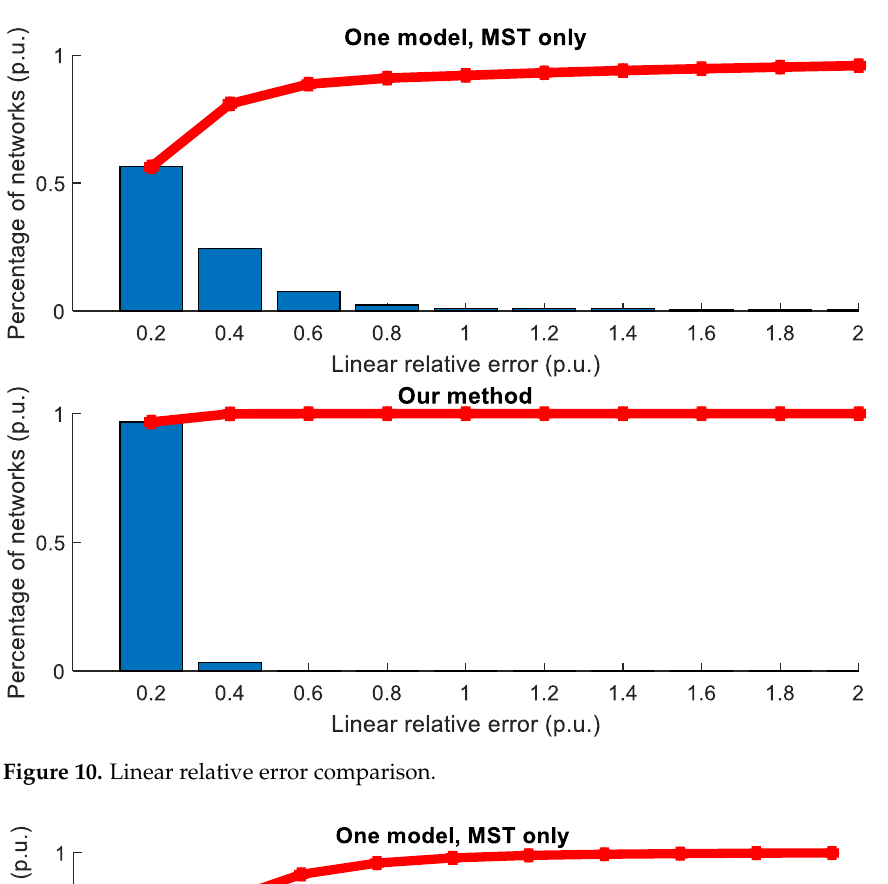
Figure 9. Linear relative error (p.u.) for each model.